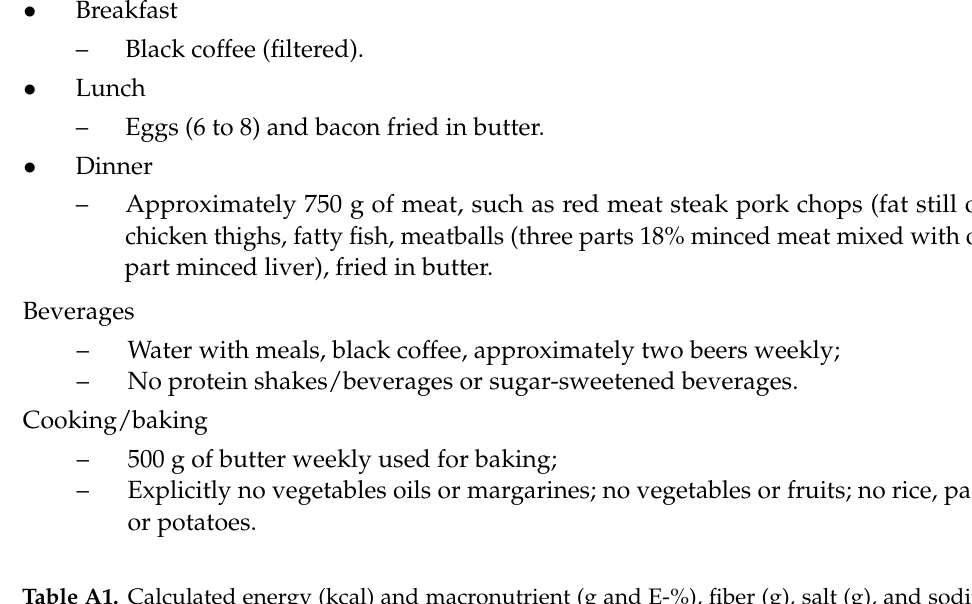
Table A1. Calculated energy (kcal) and macronutrient (g and E-%), fiber (g), salt (g), and sodium (mg) intake on an example day of case 1 on a carnivore